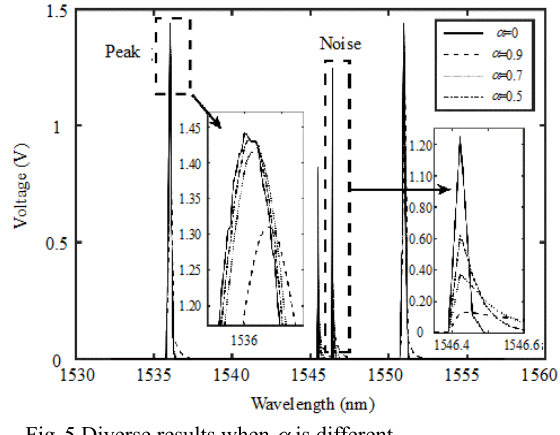
Fig. 5 Diverse results when  is